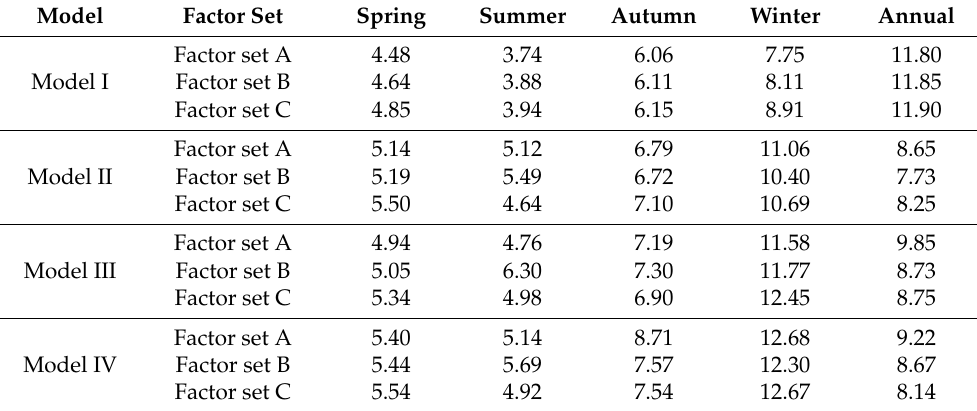
Table 4. Root mean square errors of the PM 2.5 concentration estimation model in the Chang-Zhu-Tan urban agglomeration.